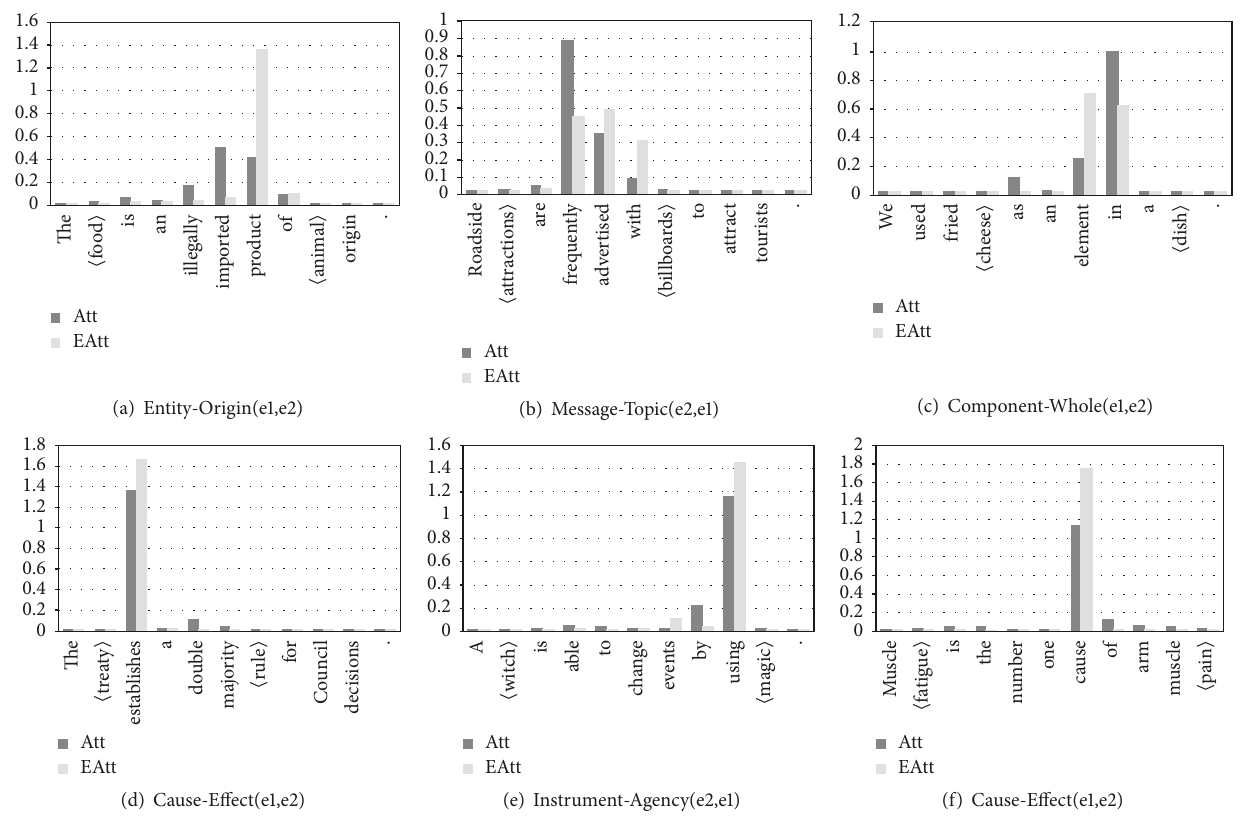
Figure 3: Attention visualization comparison between original attention mechanism and entity pair-based attention mechanism. “Att” denotes the attention mechanism which employs a random-initialized vector to generate attention weights; “EAtt” stands for the proposed entity pair-based attention mechanism.